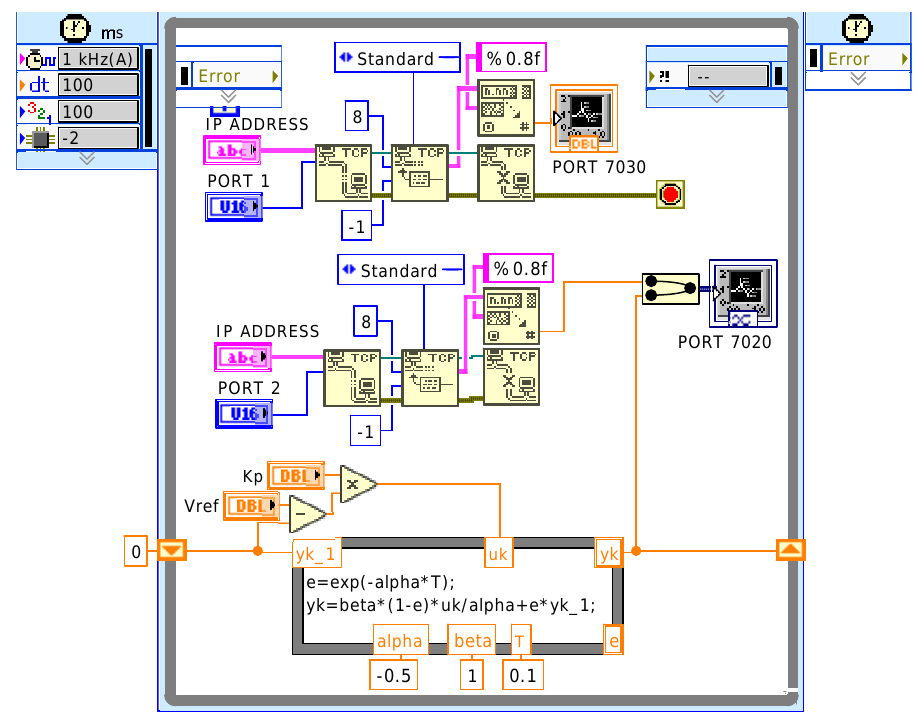
Figure 7. G Code diagram developed for Client B.